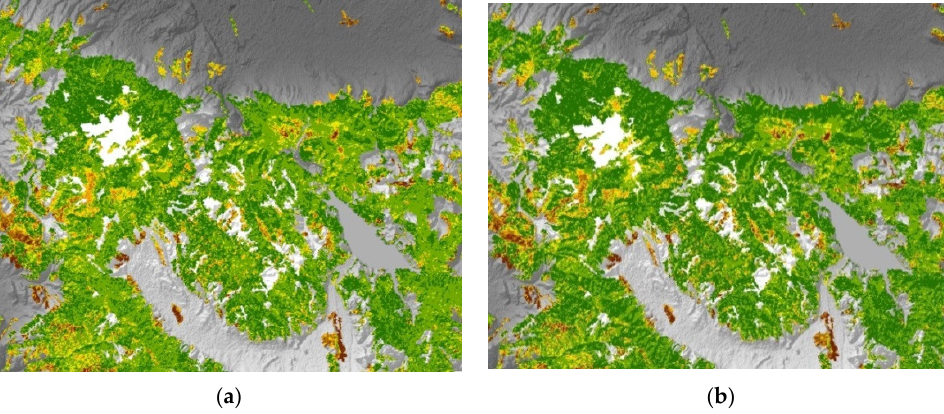
Figure 7. Distribution of Drought coefficient (DC) in Ihtimanska Sredna gora, Verila, and Plana at the beginning of September 2019 ( a ) and in the middle of September 2019 ( b ); scale 1:300,000.